Question: Provide a one-line summary of what is displayed.
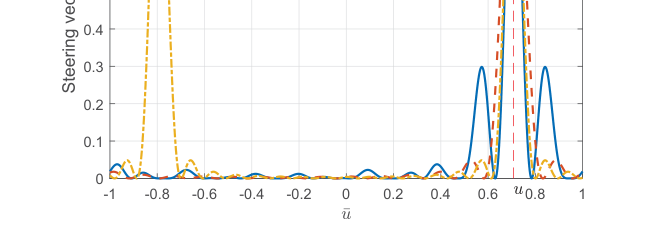
Answer: Comparison of steering vector correlation with different antennas’ positions in the case of 1D array.